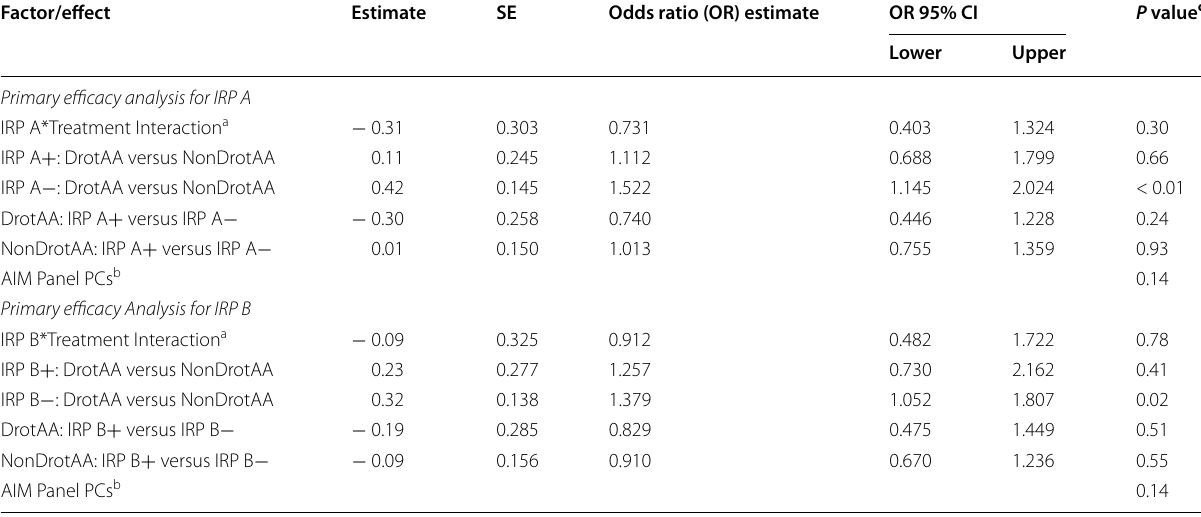
Analysis for IRP A involved 376 discordant matched sets from a total of 637 matched sets Analysis for IRP B involved 372 discordant matched sets from a total of 634 matched sets a The interaction odds ratio is a ratio of odds ratios b A total of 10 AIM Panel PCs were included which accounted for 33.9% of the variance in the AIM Panel data for the Matched-INDICATED Primary Analysis Population based on all cohorts c P values from conditional logistic regression partial likelihood ratio tests for the IRP*Treatment Interaction and the combined AIM Panel PCs; all other P values are from Wald Chi-square